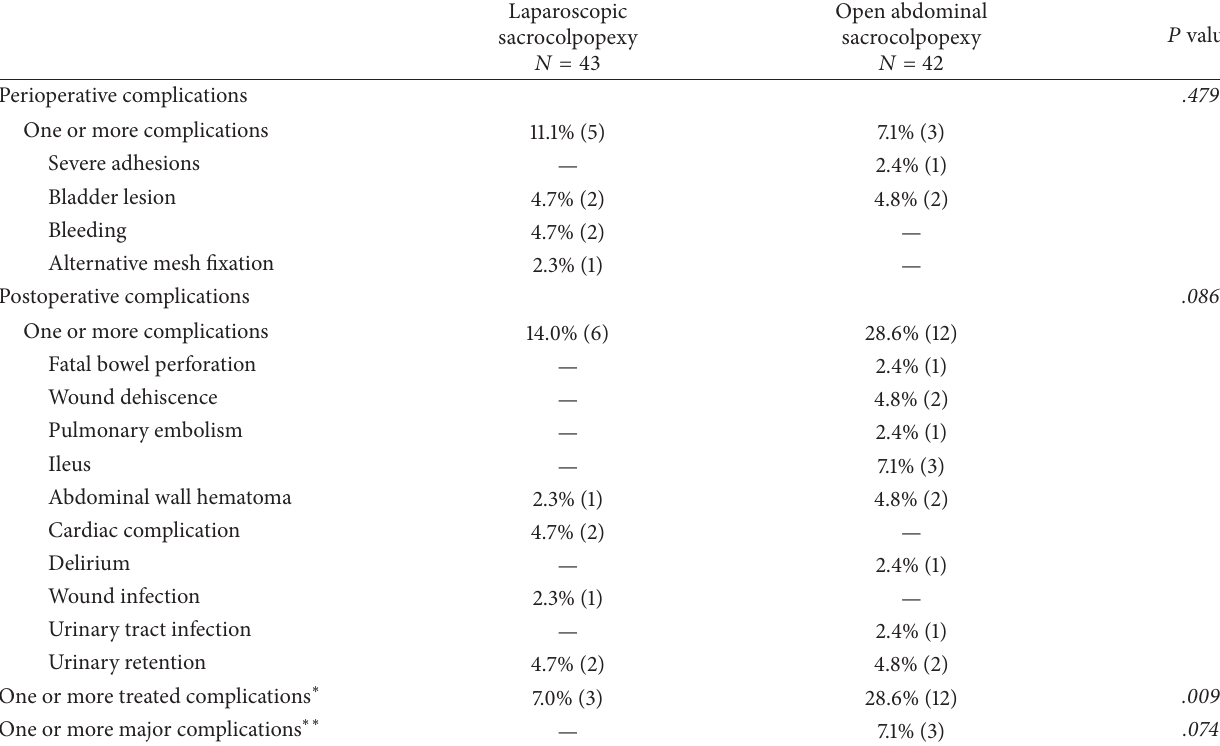
Table 4: Patients with perioperative and postoperative complications